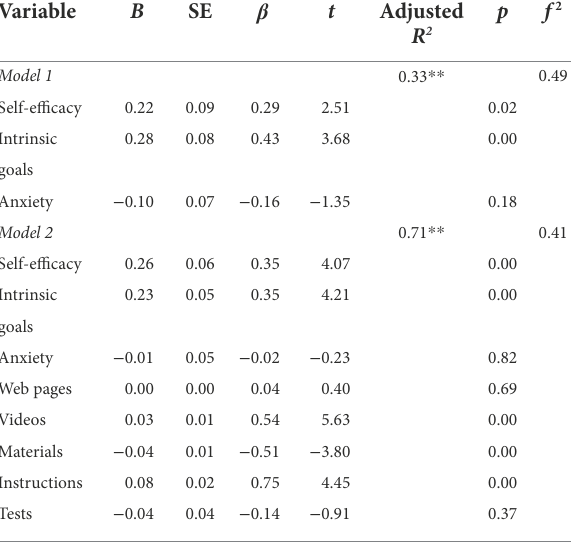
TABLE 2 Results of hierarchical regression